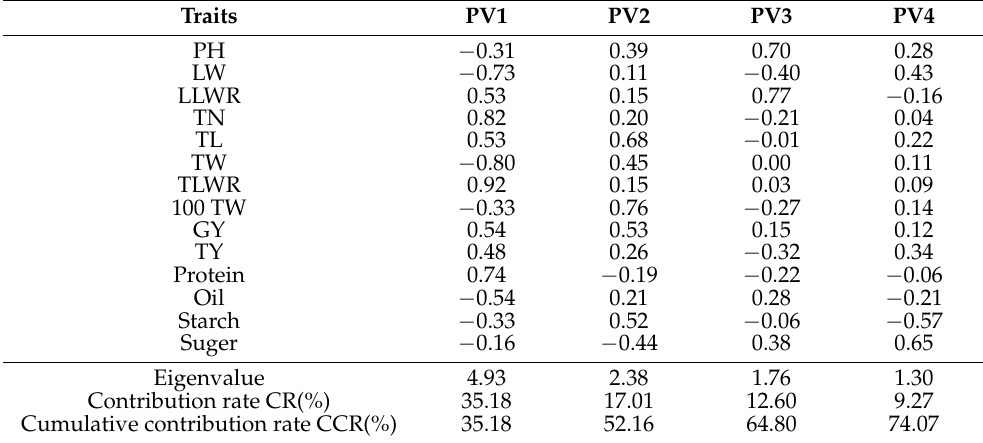
Table 5. First 4 principal components based on 14 traits by PCA analysis.